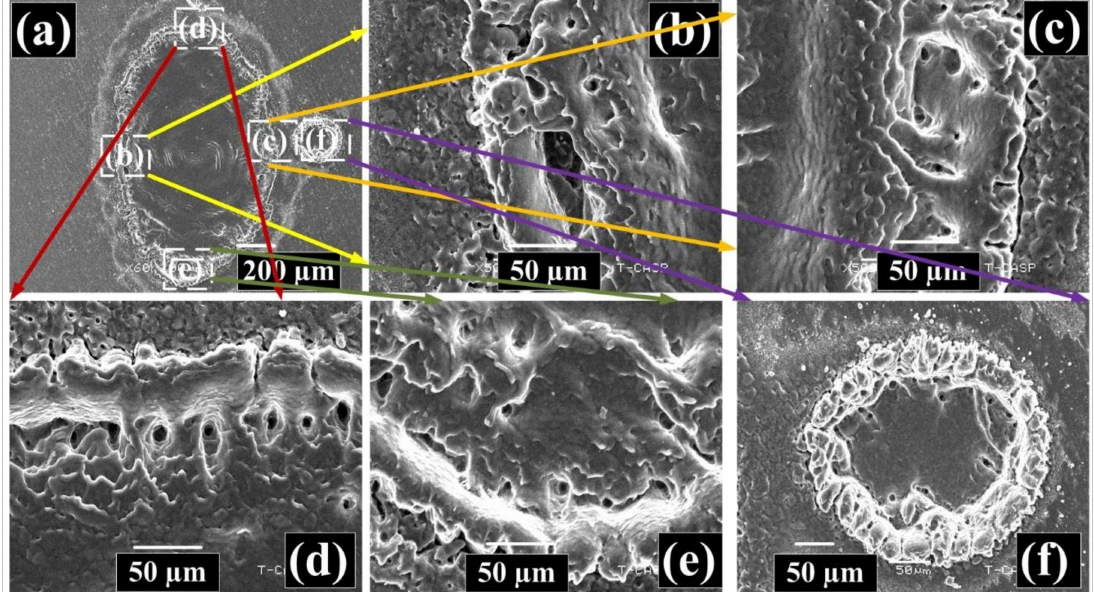
Figure 15. SEM micrographs of the laser irradiated areas of Mg exhibiting the surface morphology under ambient environment of He at a constant pressure of 5 Torr and laser irradiance of 2.0 GW/cm 2 in the presence of a magnetic field, where ( a ) laser-ablated crater of the Mg alloy, ( b ) dendritic structures, cavities, and conical protrusions at left-hand outer boundary ( c ) dendritic structures, cavities, and conical protrusions at right-hand outer boundary of the laser ablated, ( d ) dendritic structures, turbulent melt flow towards the outer boundary, and cavities at the upper outer boundary of the laser ablated crater, ( e ) dendritic structures, turbulent melt flow towards the outer boundary, and cavities at lower outer boundary of the laser ablated crater, and ( f ) micro-sized crater and forward peaked